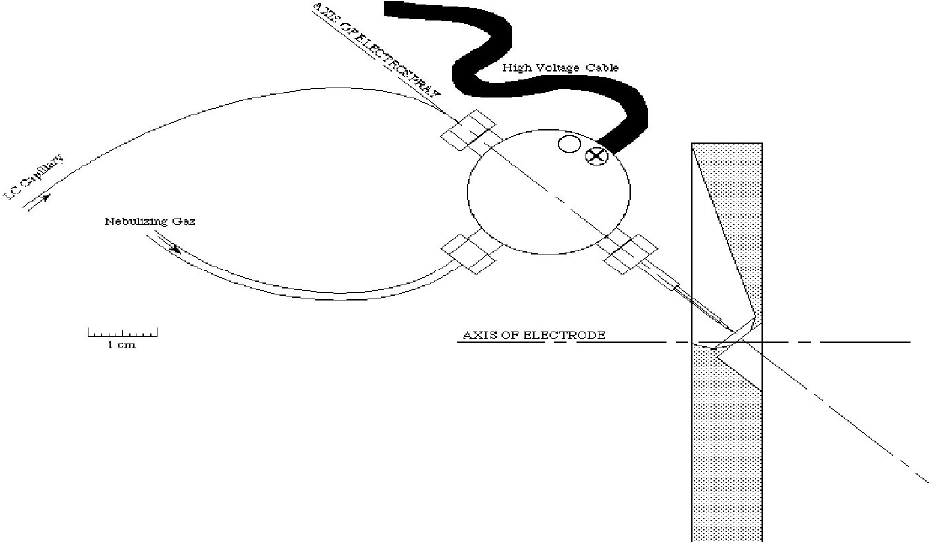
Figure 5 . Implementation of the intermediate electrode with the IonSpray TM